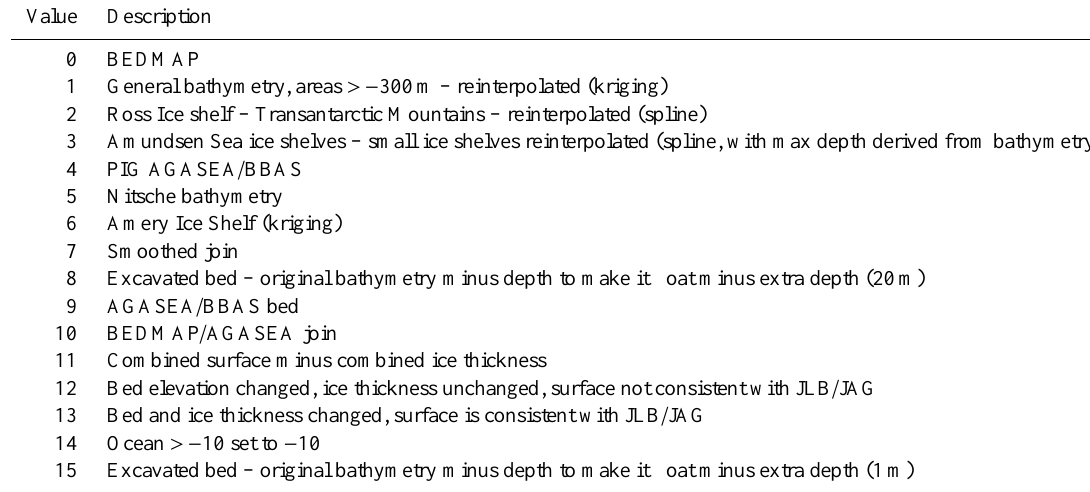
Table 4. Summary of bmask values.